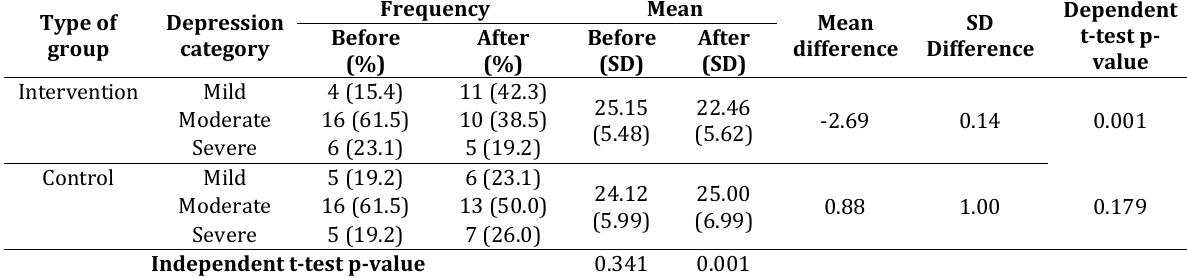
Table 1. Differences in the depression level between intervention and control groups (pre- and post-test; N = 52) Type of group